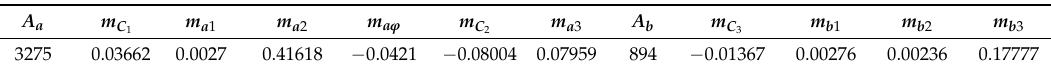
Table 2. Material-specific parameters for the flow curve terms HS a and HS b . Table 3. Material-specific parameters for the transition function (cid:2012) (cid:3009)(cid:3020) .